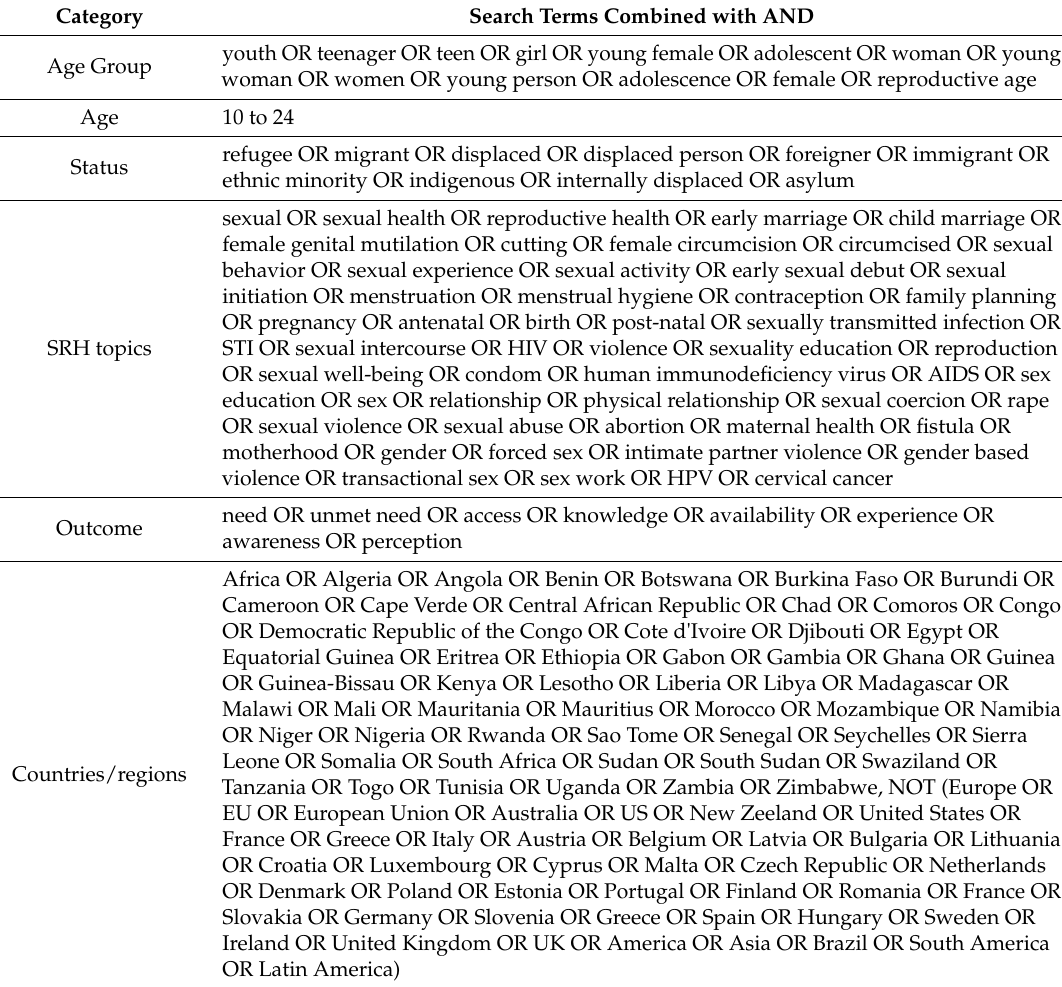
Table 1. Search terms used in PubMed and Web of